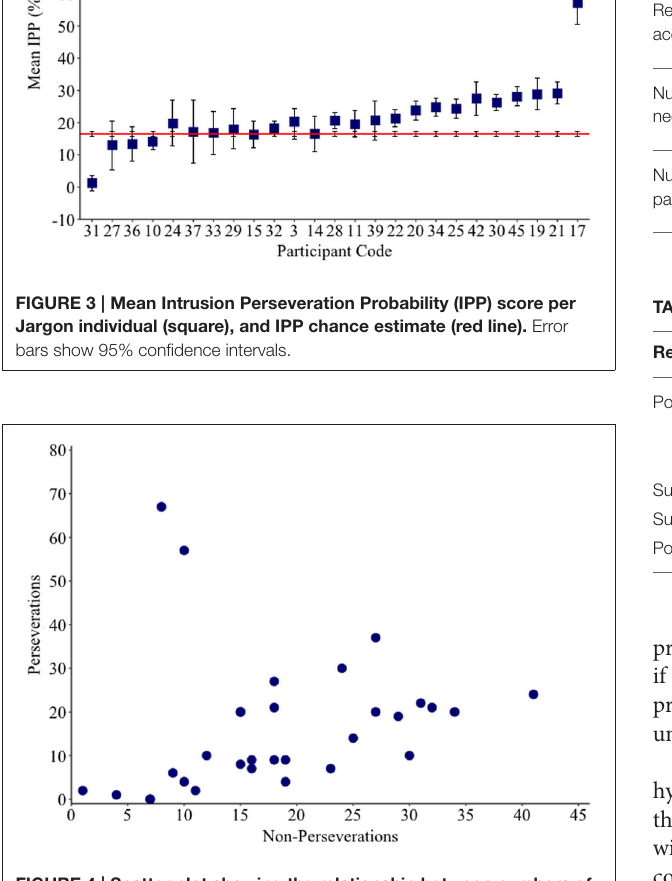
(Martin and Dell, 2007; Buckingham and Buckingham, 2011).